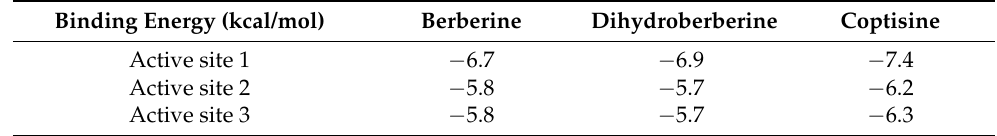
Table 5. The binding energy of ligand molecules at the active sites of the p53 protein. Binding Energy (kcal/mol) Berberine Dihydroberberine Coptisine Active site 1 − 6.7 − 6.9 − 7.4 Active site 2 − 5.8 − 5.7 − 6.2 Active site 3 − 5.8 − 5.7 −